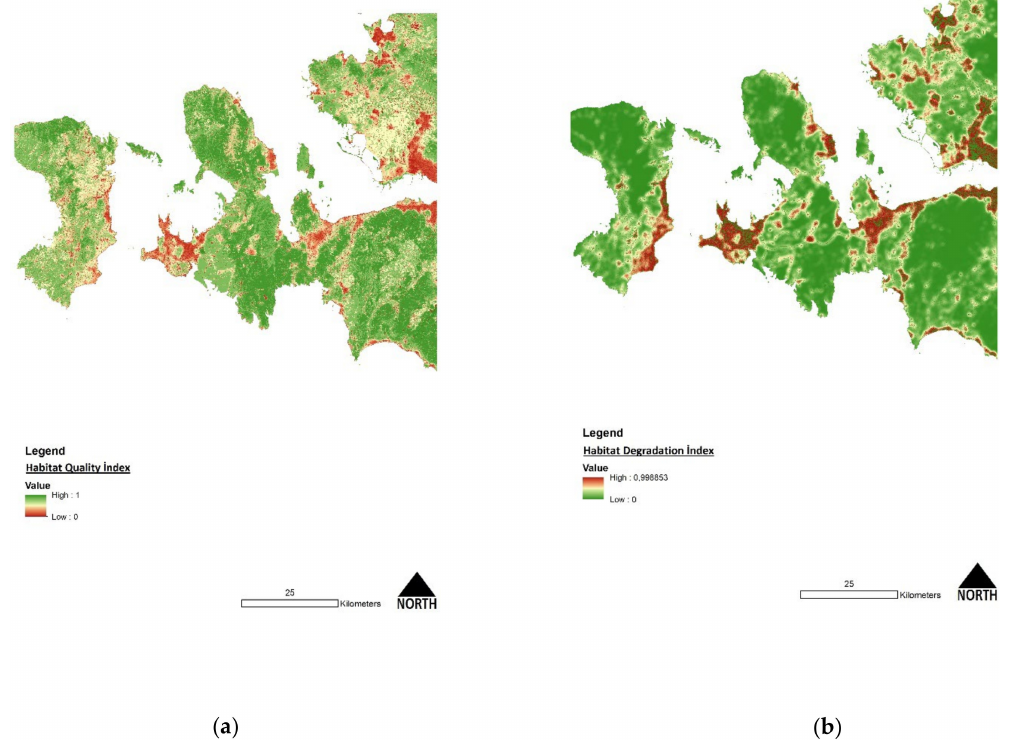
Figure 7. Habitat Quality output. ( a ) habitat quality index. ( b ) habitat degradation